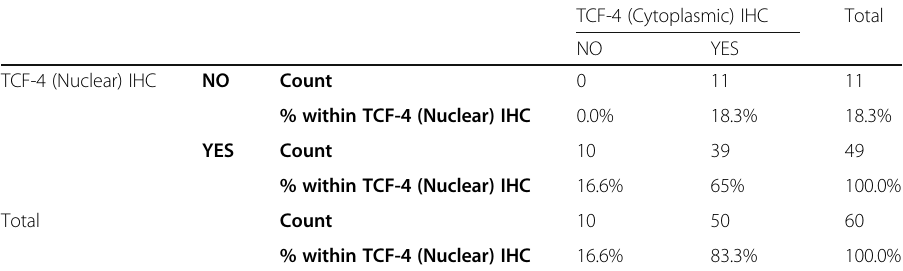
Table 2 Comparison of Nuclear & Cytoplasmic expression of TCF-4 protein in tumor